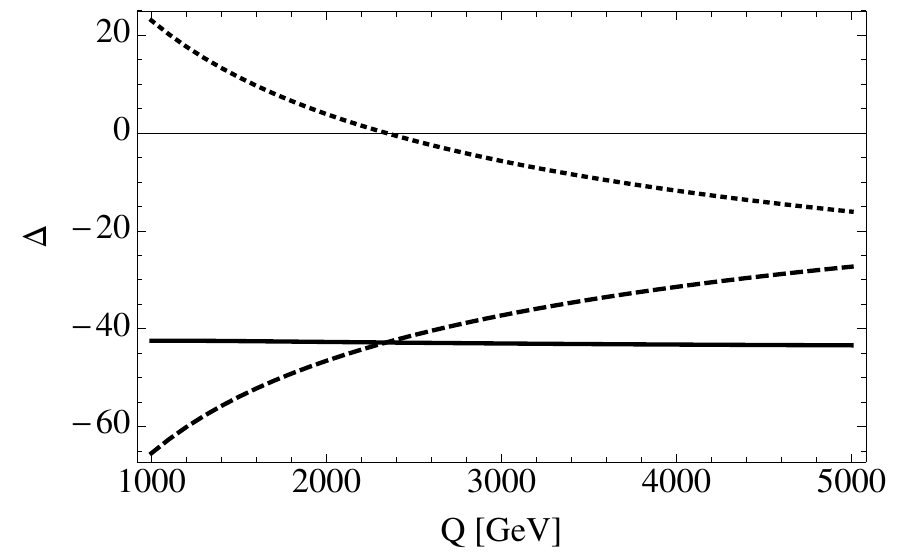
((cid:3)) = m U ((cid:3)) = 1 TeV, 3 3 ( Q ), the scale- H u ( Q ) and the threshold corrections, it is very H u